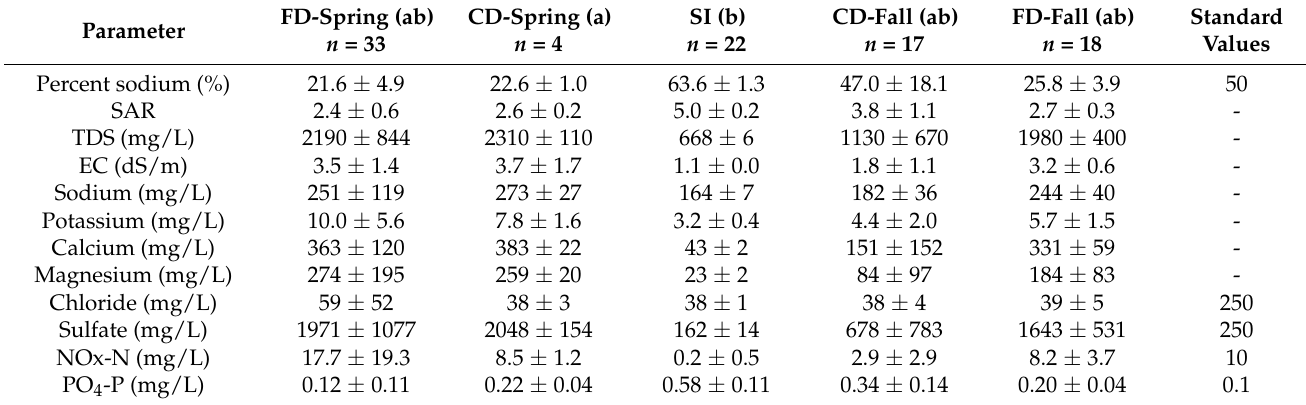
Table 2. The mean values for percent sodium, sodium adsorption ratio (SAR), total dissolved solids (TDS), electrical conductivity (EC), and chemical concentrations for sodium, potassium, calcium, magnesium, chloride, sulfate, nitrite + nitrate nitrogen (NOx-N), and orthophosphate (PO 4 -P) from the water samples at the east sump from 2012–2018 during periods of free drainage (FD), controlled drainage (CD), and subirrigation (SI). Standard values were obtained from the North Dakota Standards of Quality for Waters of the State when listed. Significant differences as determined by Tukey’s honestly significant difference post hoc test with an alpha value of 0.05 are shown by different letters. Sample size ( n ) is given below each column title and standard deviations are listed for each